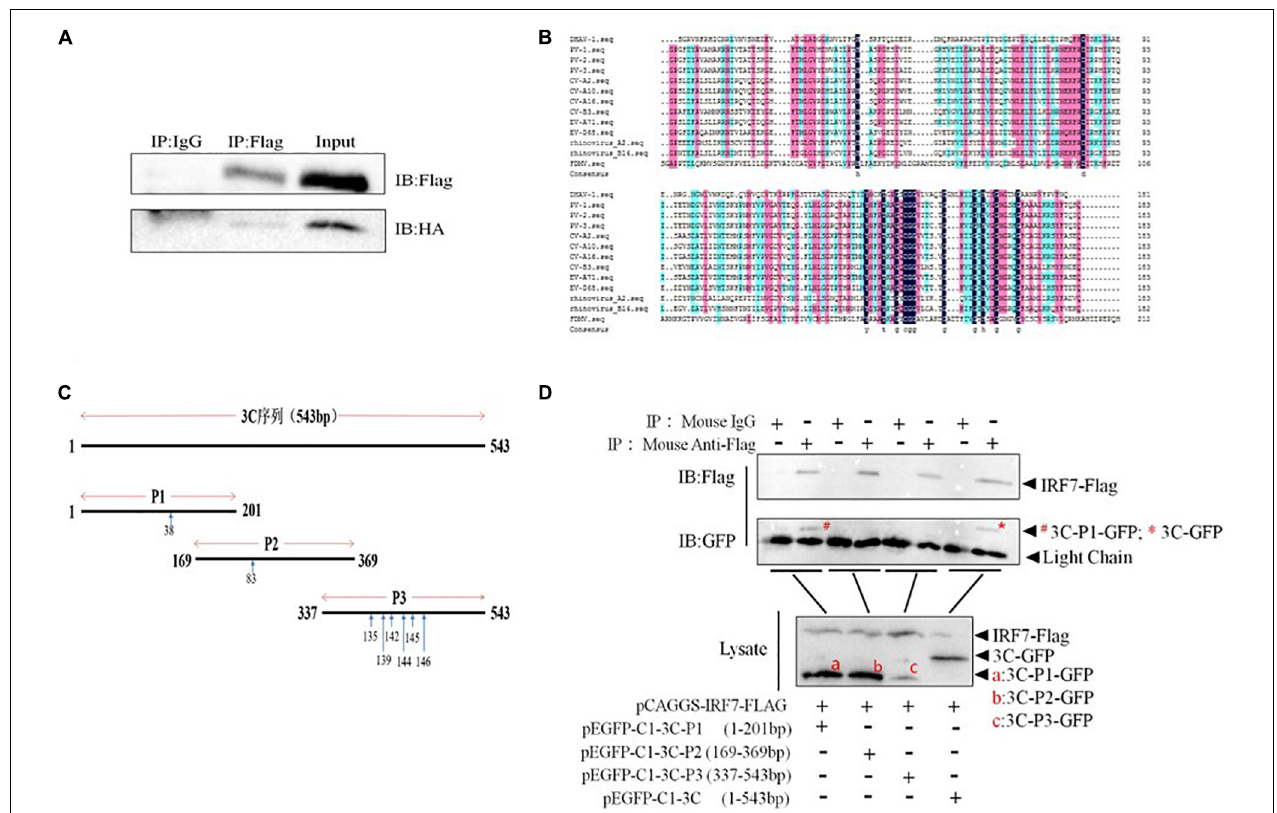
FIGURE 6 | Interaction between the 3C and IRF7 proteins. HEK-293T cells were transfected with pCAGGS-IRF7-Flag and pCMV-3C-HA, pEGFP-C1-3C-P1, pEGFP-C1-3C-P2, pEGFP-C1-3C-P3, or pEGFP-C1-3C at a transfection ratio of 1:3, and 36 h after transfection, cell samples were collected for immunoprecipitation experiments. (A) The interaction between the 3C and IRF7 proteins. (B) Comparison of 3C protein amino acid sequences. (C) Schematic diagram of the truncated 3C protein plasmid, with blue arrows indicating conserved amino acid positions. (D) The region through which the 3C protein binds the IRF7 protein was